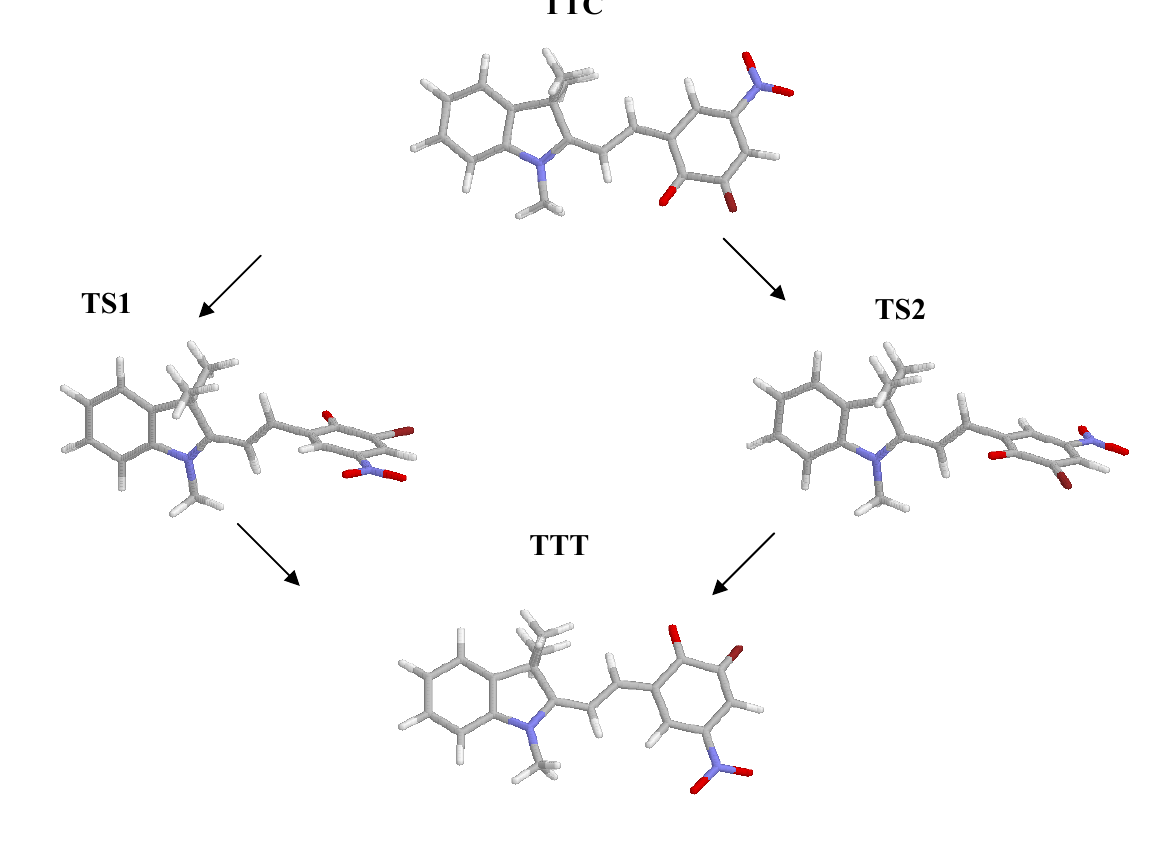
Figure 2. Optimized structures of TTC, TTT and of the transition